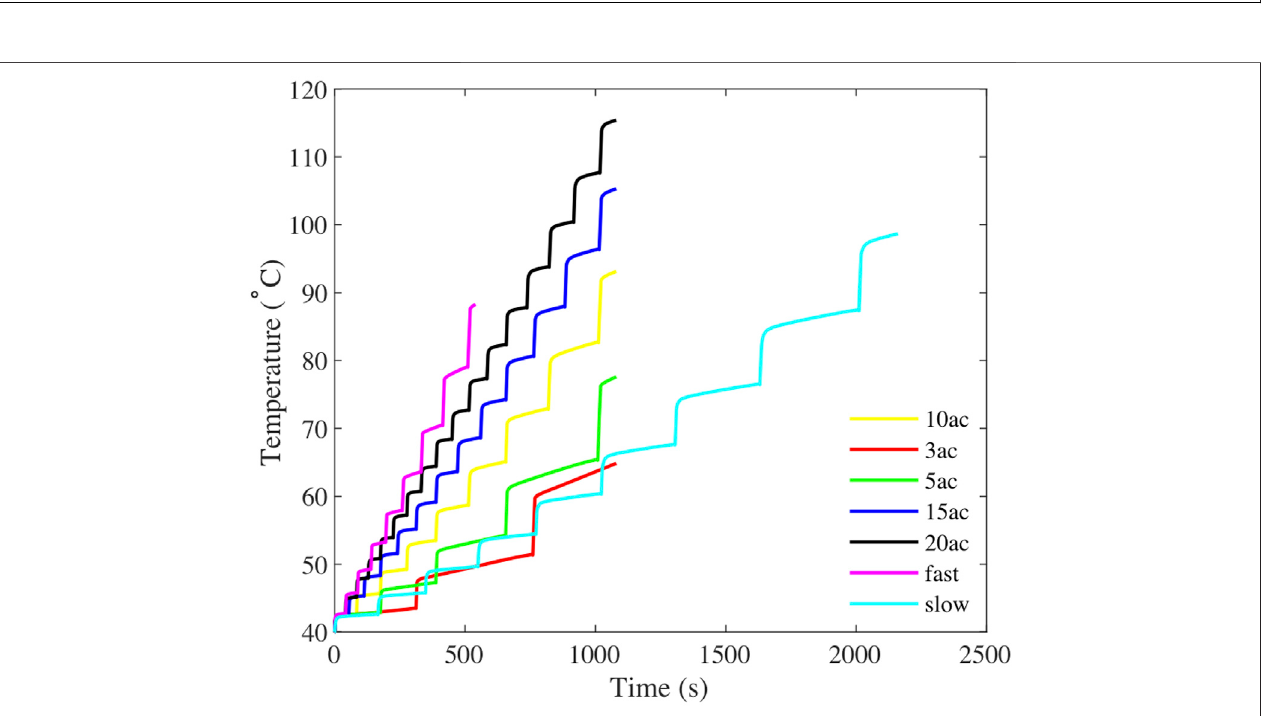
FIGURE 9 | Pressured oil temperatures of IHESS in different